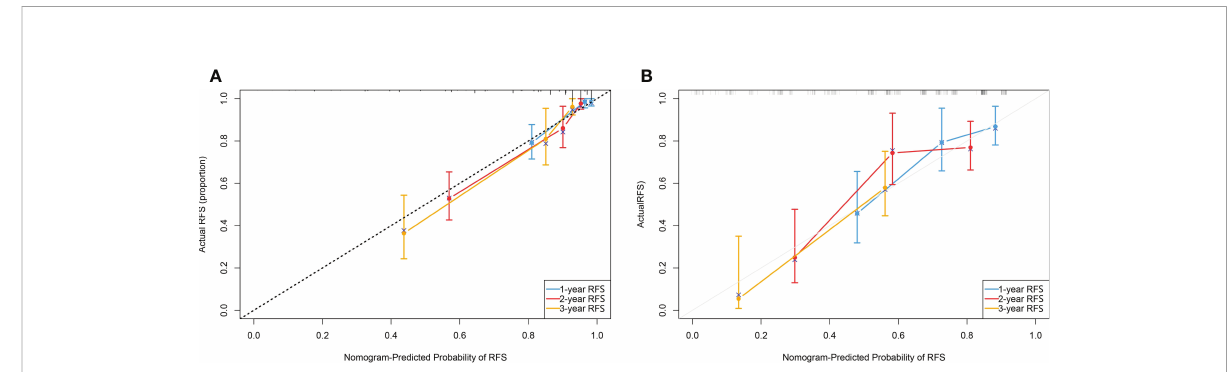
FIGURE 6 (A) Calibration plot of the nomogram done by bootstrapping with 1,000 resamples for predicting recurrence-free survival(RFS) in the training cohort. (B) Calibration plot of the nomogram done by bootstrapping with 1,000 resamples for predicting recurrence-free survival in the external validation